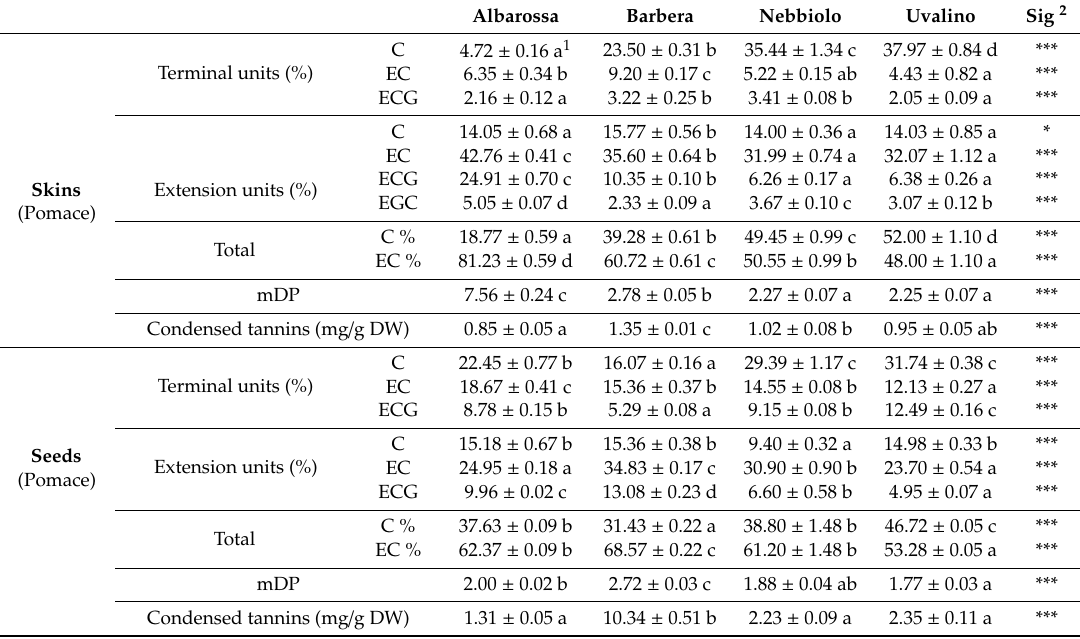
Table 6. Concentration, monomer percentage composition and mean degree of polymerization of condensed tannins in the pomace skins, and ANOVA results. C = ( + )-catechin, EC = ( −